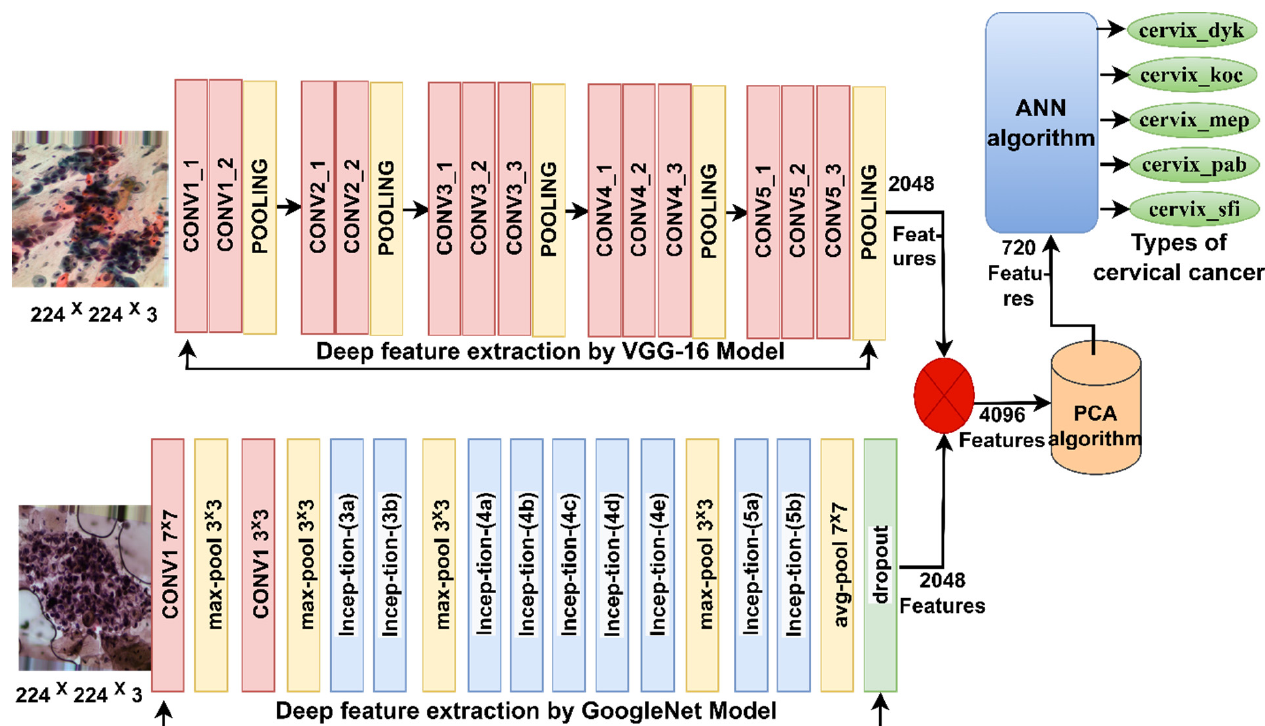
Figure 4. Framework for a feature fusion approach of the VGG-16 and GoogLeNet models for cervical cancer data set diagnosis.